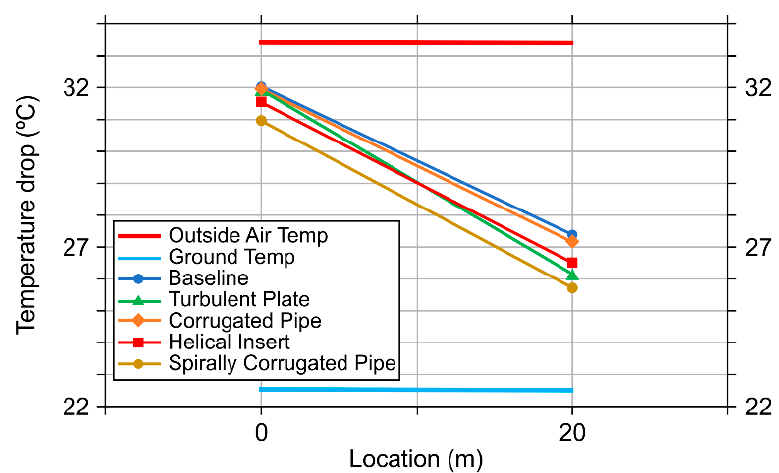
Figure 13. Temperature drop for the five investigated pipes.